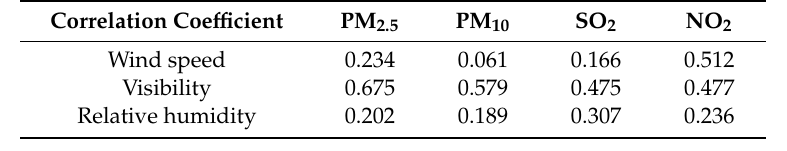
Table 3. Correlation coe ffi cients ( R ) of the relationships between four major air pollutants and three meteorological elements ( n = 731).